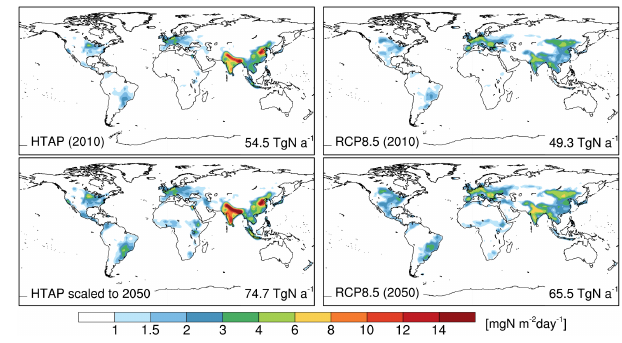
Figure 1. Average annual emissions of NH 3 for 2010 (top row) and 2050 (bottom row) based on anthropogenic NH 3 emissions from HTAP_v2 (left column) and from RCP8.5 (right column). Non an- thropogenic emissions (including biomass burning) are the same in all scenarios. Total annual emissions are indicated